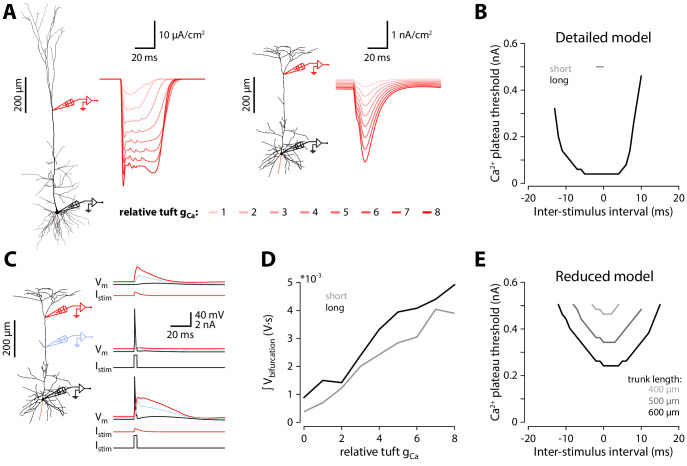
Exploration of Ca2+ electrogenesis under diverse stimulus timings and intensities.(A) Calcium current densities at the apical bifurcation during coincident stimulation for different relative levels of tuft gCa (as in Figure 3B). N.B. there is a factor of 104 difference in scale between the traces for the long and short morphology. (B) Smallest dendritic current required to trigger a Ca2+ plateau in the long and short detailed models during coincident stimulation with different time intervals between the somatic and dendritic stimuli. Ca2+ plateau threshold: 1.25 μA/cm2. (C) Voltage traces for the short morphology during the strongest stimulation (Δt = 0; 0.5 nA). (D) Integral of the voltage at the apical bifurcation of the long and short models during the strongest stimulation (Δt = 0; 0.5 nA) with different levels of tuft gCa. (E) Same as in A, but for the reduced model. Trunk lengths of 300 μm and lower did not elicit Ca2+ plateaus for any amplitude of current injection.